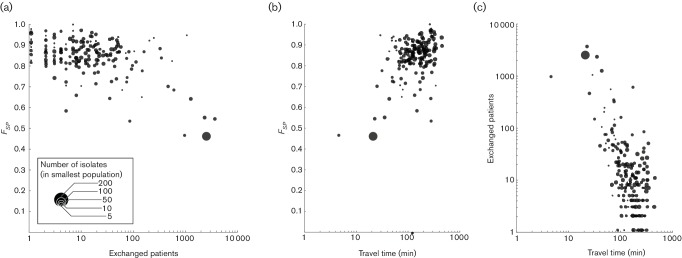
The FSP between all pairs of available hospitals in England as a function of distance between them, with circle size denoting the size of the smallest population size of the two. (a) Expressing distance as the number of patients exchanged between them on a yearly basis. With increasing number of exchanged patients, the hospitals’ populations become genetically more similar. (b) Hospitals in close geographical proximity, expressed in travel time by car between them, have genetically more similar MRSA populations. (c) Patient transfers have a strong geographical component, with more patients being transferred between hospitals in close geographical proximity.